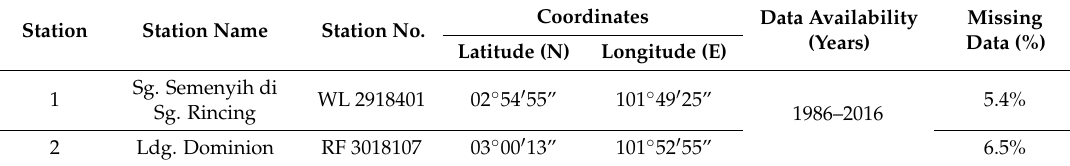
Table 3. Details on rainfall and water level gauging stations.